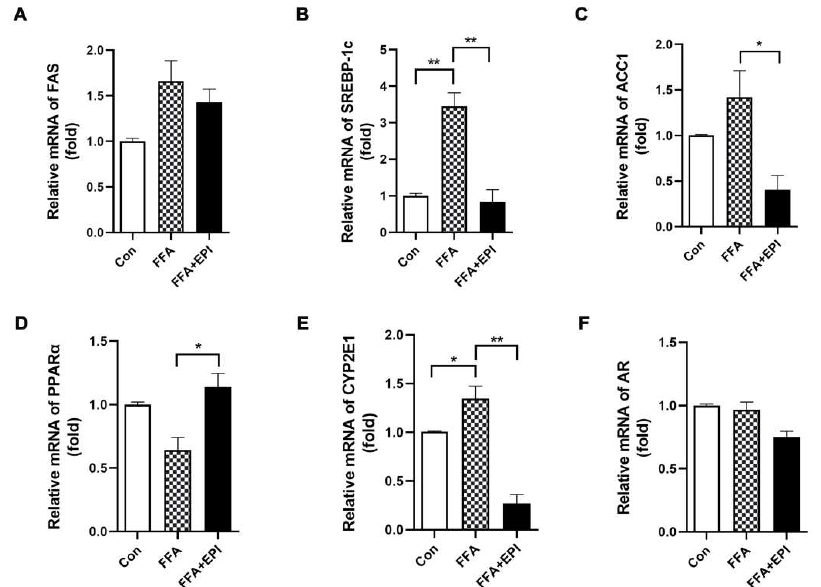
Figure 4. Quantification of lipid synthesis-related gene expression by RT-qPCR assay in human hepatic cells. EPI (EPI-001) inhibited the expression of ( A ) FAS (fatty acid synthase), ( B ) SREBP-1c (sterol regulatory element-binding protein-1c), and ( C ) ACC1 (acetyl-CoA carboxylase 1); ( D ) EPI enhanced the expression of PPAR α (peroxisome proliferator-activated receptor- α ); ( E ) EPI inhibited the expression of CYP2E1 (Cytochrome P450 2E1); ( F ) The effect of EPI on the expression of AR (androgen receptor). (mean ± SEM, * p < 0.05, ** p < 0.01, for cell experiment, the result from at least three independent experiments).